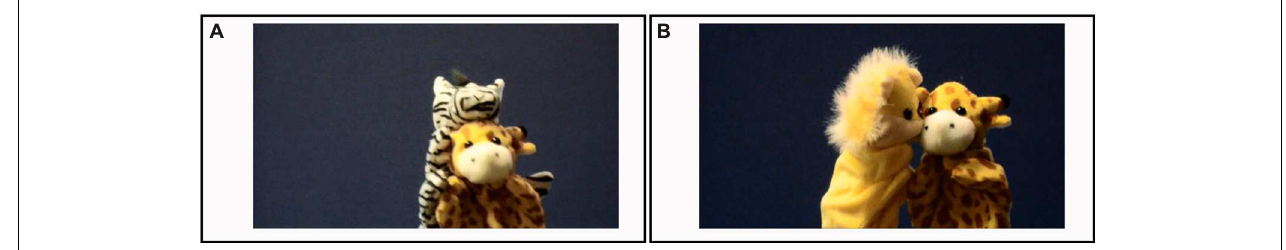
FIGURE 1 | Example stills from training videos in Experiment 1. (A) Action = zebra jumps on giraffe, accompanied by a spoken AP order sentence (e.g., pelk zebra giraffe ). (B) Action = lion kisses giraffe, accompanied by a spoken PA order sentence (e.g., fenk giraffe lion ka ).